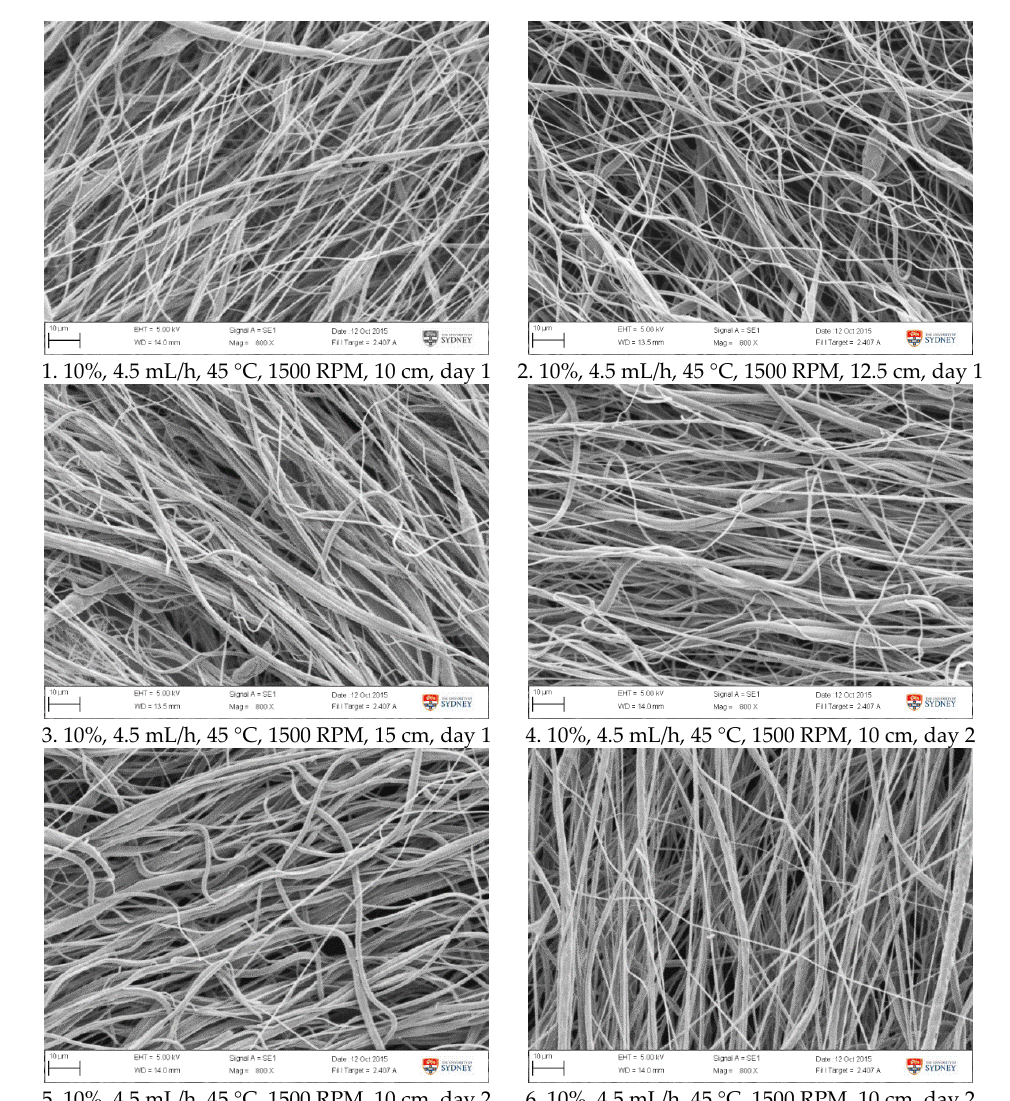
Figure A1. SEM images of fibre morphology from RSM runs.